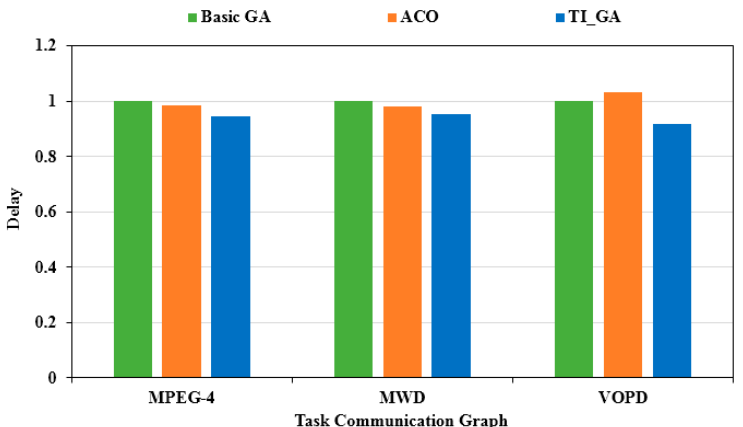
Figure 10. TI_GA, traditional genetic algorithm and ACO for MPEG-4, MWD, VOPD power results comparison ( μ e : μ d = 2:1).